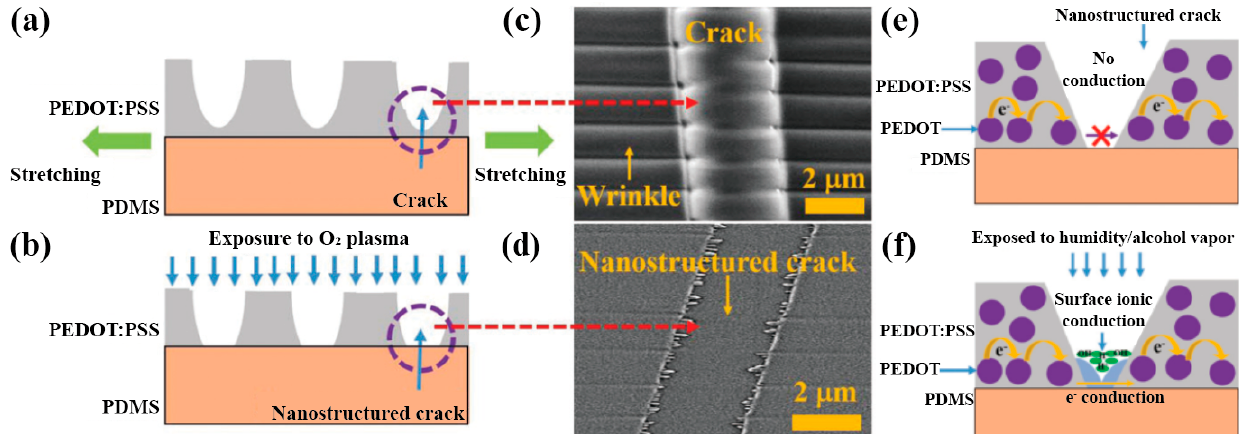
Figure 11. Cross-section schematic diagrams of the uniaxially strained film ( a ) and nanostructured crack morphology of a stretched PEDOT:PSS thin film ( b ) after O 2 plasma etching; SEM images of the surface morphology of a 20% strained PEDOT:PSS thin film ( c ) and a PEDOT:PSS thin film with nanostructured cracks ( d ); Cross-section schematic diagrams of nanostructured PEDOT:PSS thin film ( e ) and its exposure to high humidity/alcohol vapors ( f ). The tapering of the crack near the substrate is shown by the blue region. The yellow arrow indicates the electron percolation pathway [99].